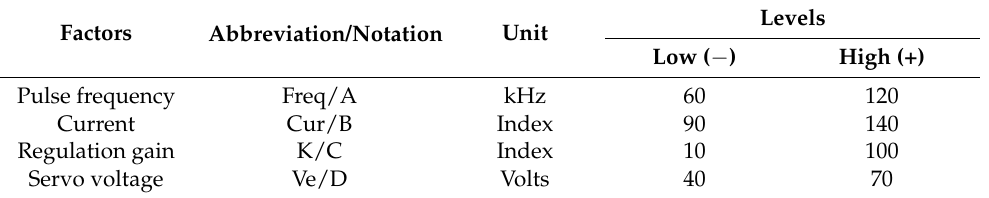
Table 1. Input factors with their levels for full factorial